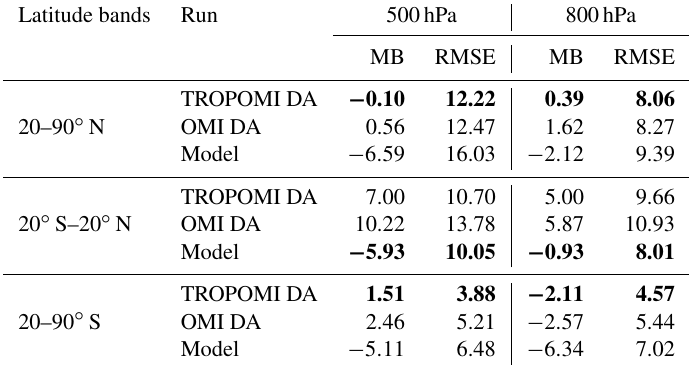
Table 9. Mean bias (MB) and root-mean-square error (RMSE) for ozone concentrations at 500 and 800hPa against ozonesonde observations over three latitude bands from 15 April–31 May 2018. The units of MB and RMSE are in parts per billion by volume (ppbv). Boldface denotes the best agreement with in situ observations. “Model” indicates the control model simulation. Latitude bands Run 500hPa 800hPa MB RMSE MB RMSE TROPOMI DA −